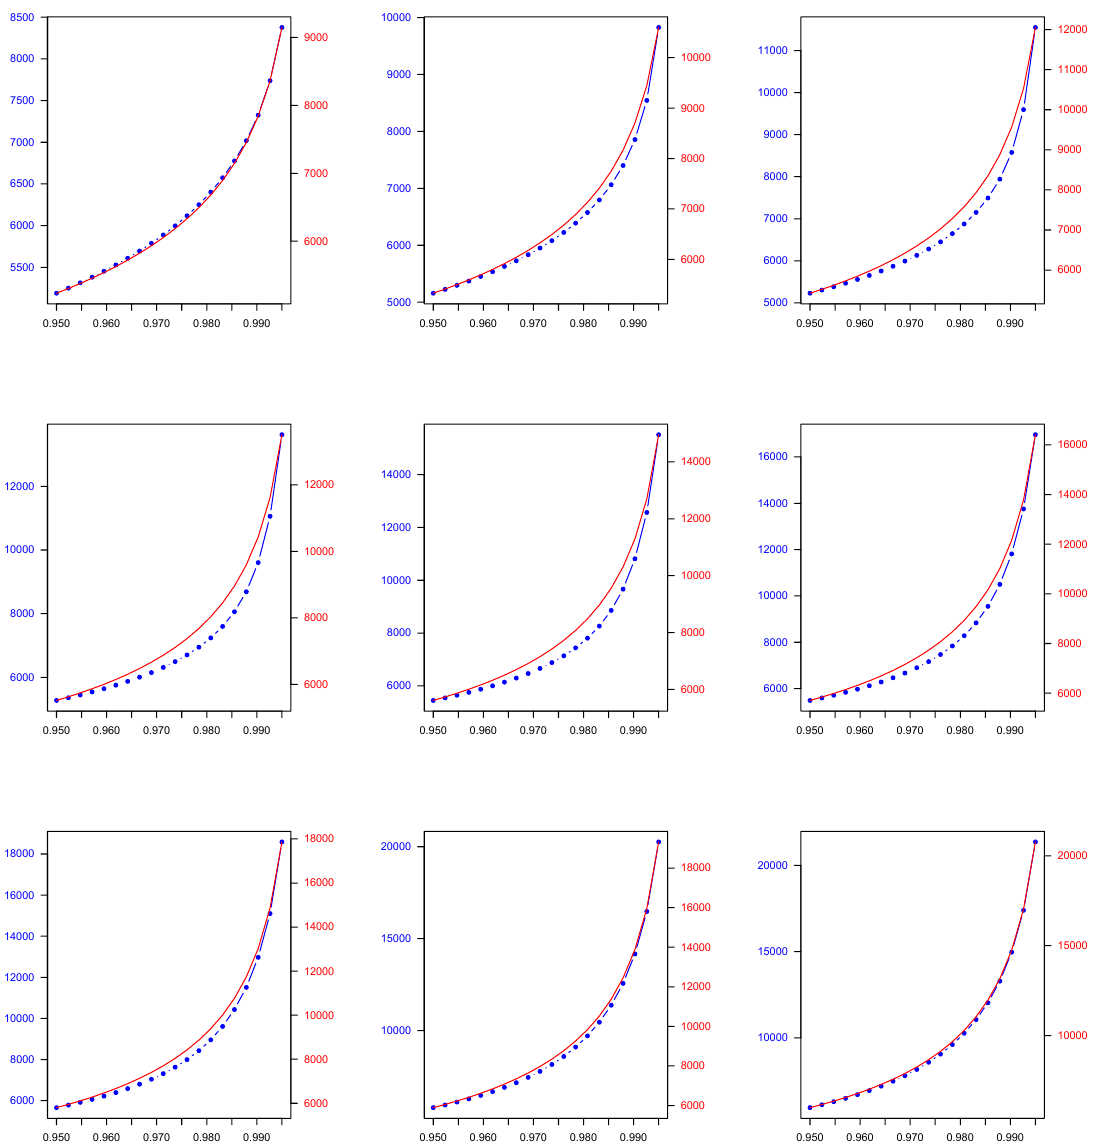
Figure 6. Two-Component (2C) Pareto-Gamma finite mixture model-based (1 − α ) quantile Q mix . (blue colour) across all ( ˆ π 1 , ˆ π 2 ) combinations versus two-component (2C) Pareto-Gamma weighted average-based (1 − α ) quantile Q w . a . (red colour) across all ( π 1 , π 2 ) combinations, where (1 − α ) takes values in the range of 0.950-0.995. Note that, due to a considerable discrepancy between Q mix . and Q w . a . values, each given plot has two different y axes—one for each quantile